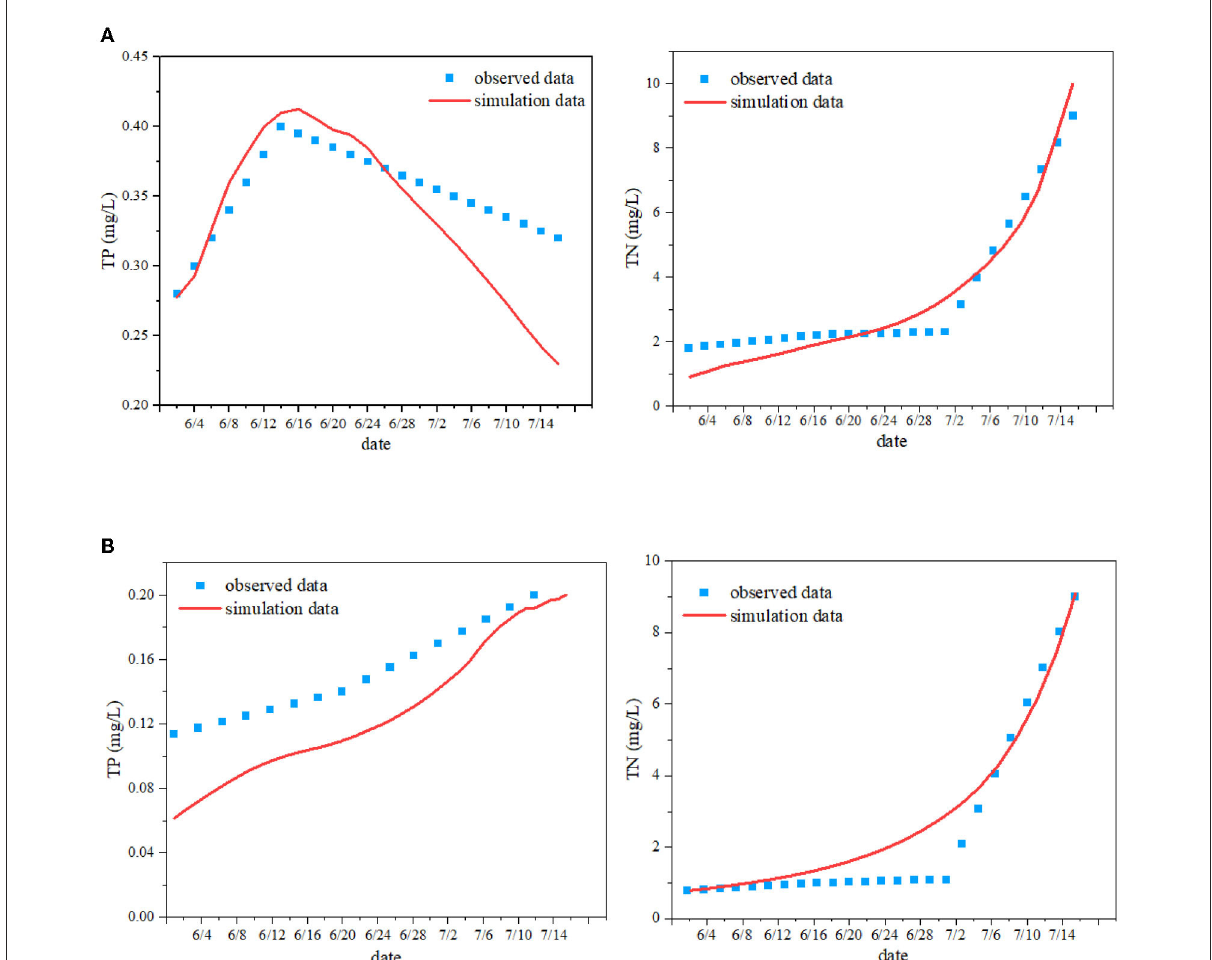
FIGURE11 Comparison between observed data and simulation data at monitoring stations 13 and 14. (A) Monitoring station 13. (B) Monitoring station 14.